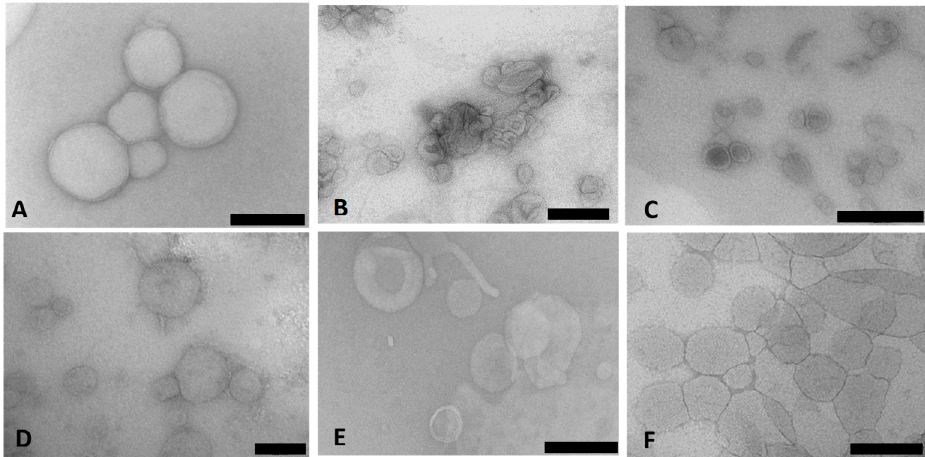
Figure 1. Transmission electron micrographs of cationic liposome: siRNA lipoplexes (N/P (+/ − ) charge ratios): ( A ) Chol-T; ( B ) Chol-T 2% PEG2000; ( C ) Chol-T 5% PEG2000; ( D ) MS09; ( E ) MS09 2% PEG22000; ( F ) MS09 5% PEG2000. Scale Bar = 100 nm ( D ) or 200 nm ( A – C , E , F ).